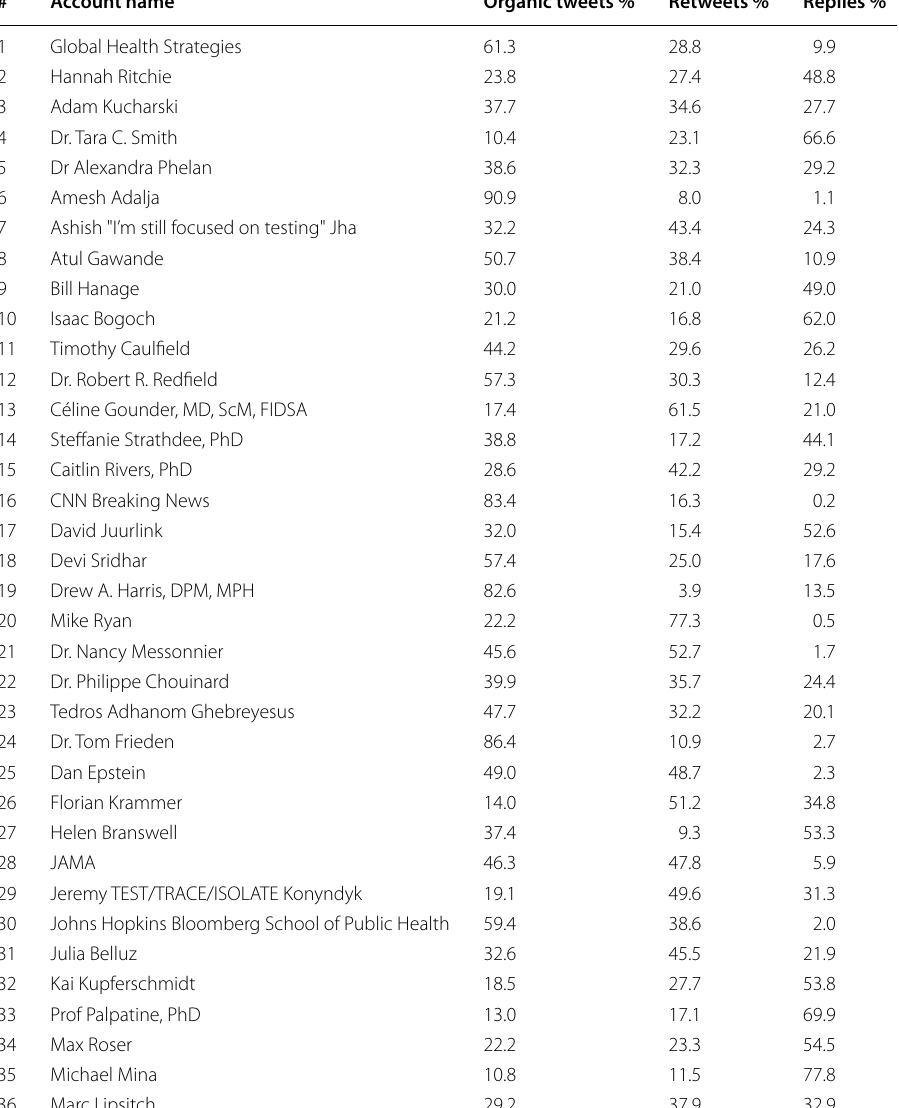
Table 6 Percentage of organic tweets, retweets, and